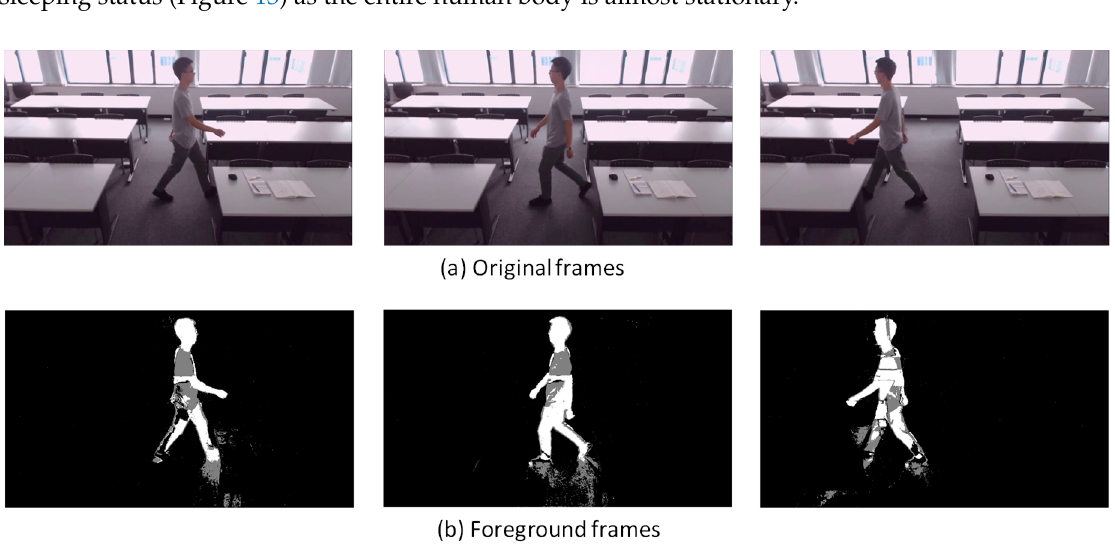
Figure 8. Walking (1.2 m/s)—sample images.